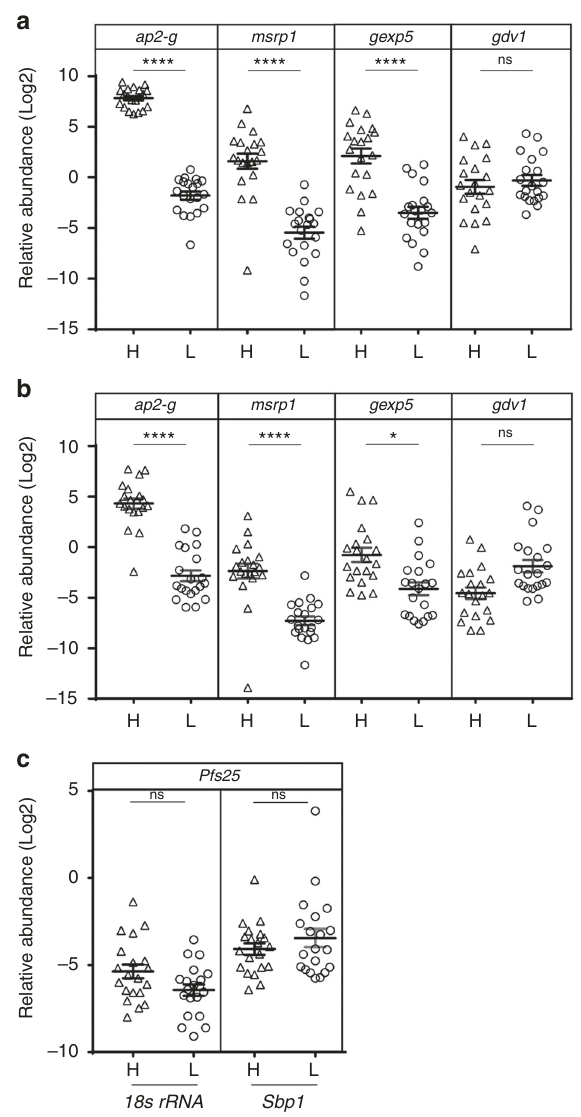
Fig. 4 In vivo, high gametocyte conversion is associated with high ap2 - g , msrp1 and gexp5 transcript levels. a , b The relative abundance (2 − ΔΔ C T ) of the transcript levels of the indicated genes were determined for malaria patient samples in the high GCR (H, triangles, n = 20) and low GCR (L, circles, n = 20) cohorts using 18s rRNA ( a ) or sbp1 ( b) RNA levels as the endogenous control. The reference sample was RNA from Pfgdv1.gfp.dd .T1 parasites grown in the absence of Shld1 to inhibit gametocyte production. c The relative abundance (2 − ΔΔ C T ) of Pfs25 transcripts in the high GCR (H, triangles, n = 20) and low GCR (L, circles, n = 20) cohorts was determined using 18s rRNA or sbp1 RNA as the endogenous control and, again, the reference was RNA from Pfgdv1.gfp.dd .T1 parasites grown in the absence of Shld1 to inhibit gametocyte production. The experiment was performed in duplicate and the means and s.e.m. are shown. A Kruskal – Wallis test followed a Dunn ’ s multiple comparison test was used to compare between high and low converters and probability is indicated, p >0.05 (ns), p <0.05 (*) and p ≤ 0.0001